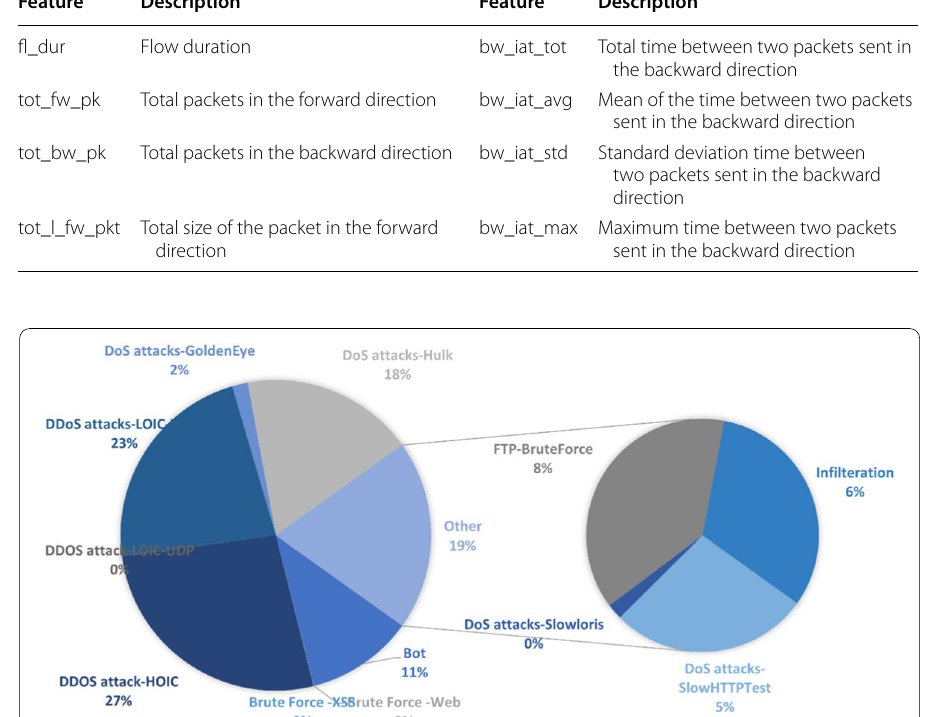
Fig. 1 Distribution of different categories of attacks in the